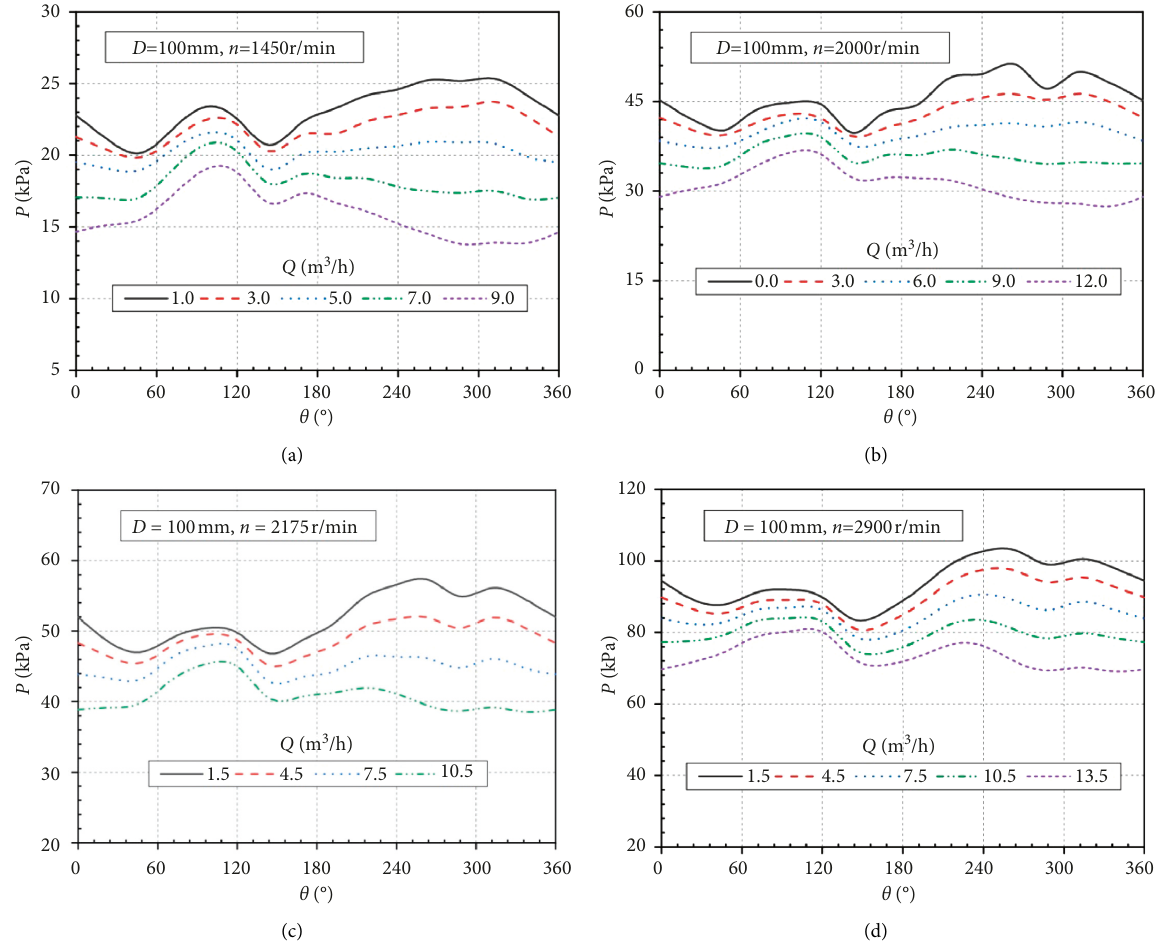
Figure 9: Average static pressure distribution at the front wall of volute casing ( D �